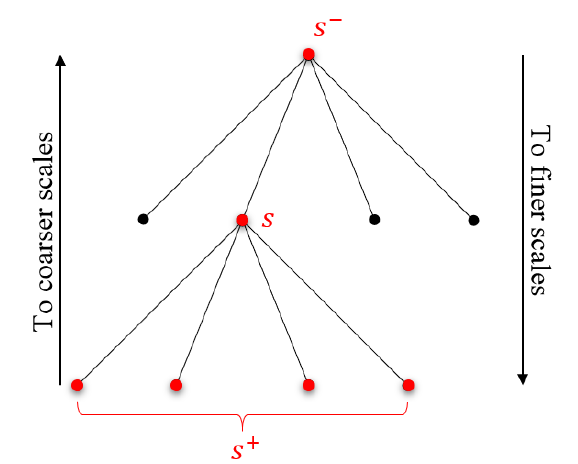
Figure 1. Structure of the quadtree and the corresponding parent–child